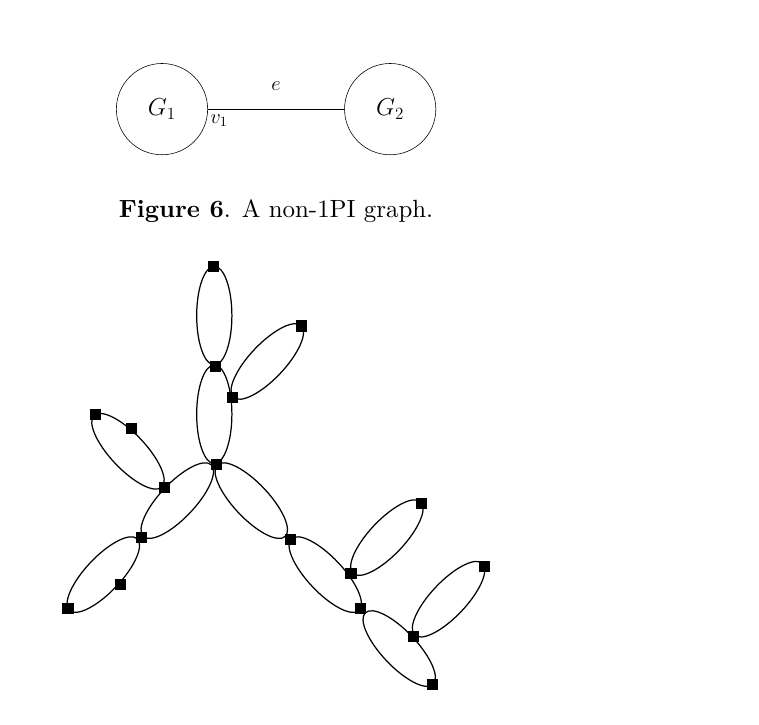
Figure 7 . A generic 1PI cactus diagram. It is a tree of bubbles, with the nodes between the bubbles being vertices, and any other vertices of degree 2 can appear on the